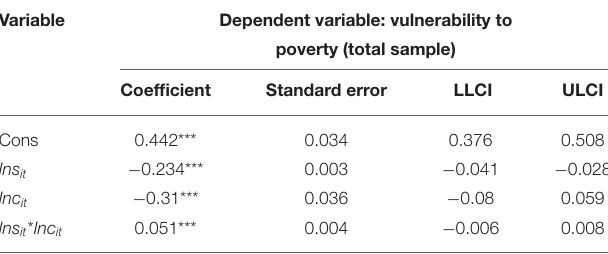
TABLE 8 | Test of additional income as an intermediary